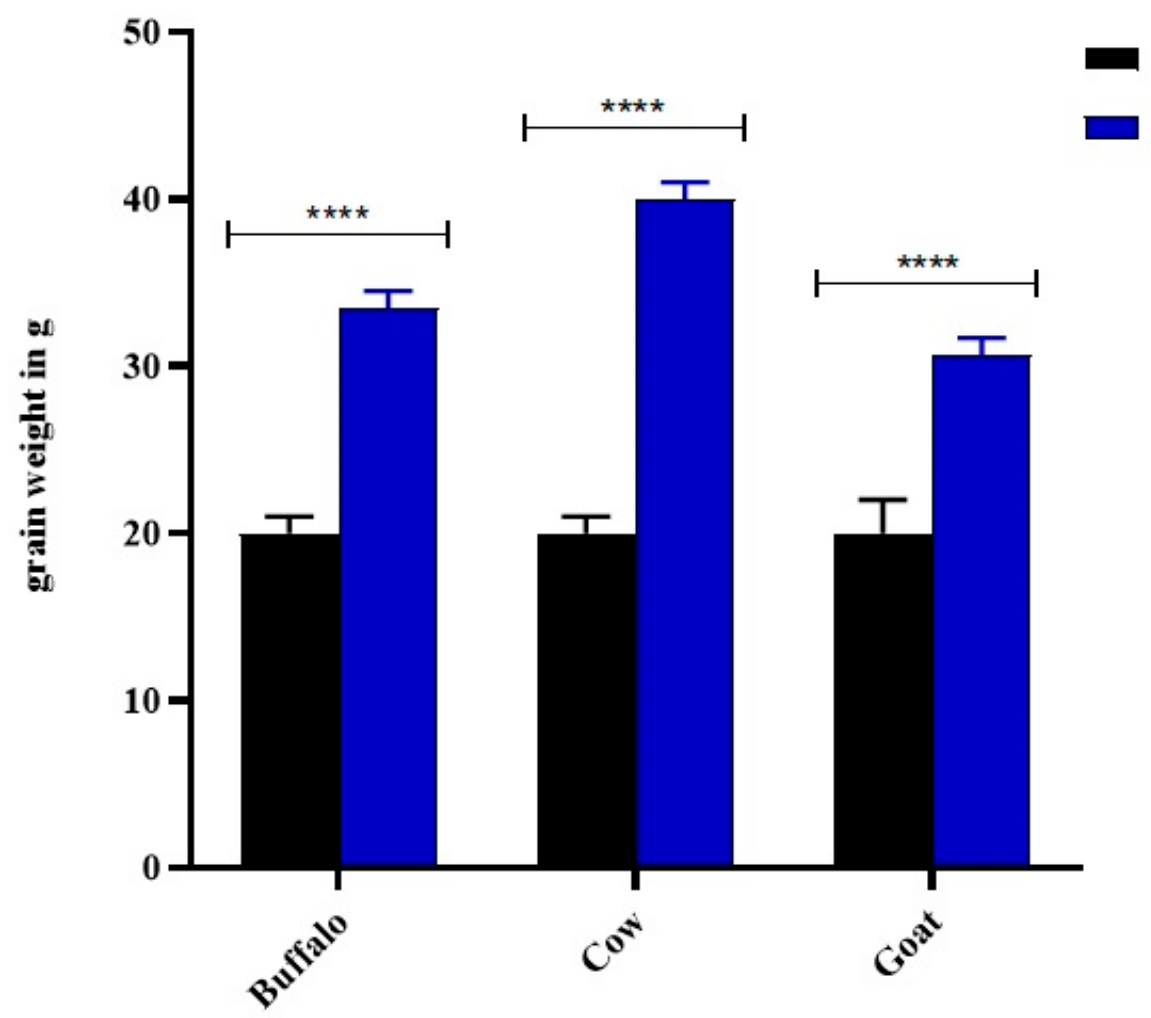
Figure 2. Mean values of grain weight ± standard deviation at 0 h and 24 h of fermentation time. Histograms and error bars represent the mean of independent experiments performed in triplicate and standard deviation, respectively. Asterisks on bars indicated that mean values were statistically different from time zero (**** p < 0.0001).